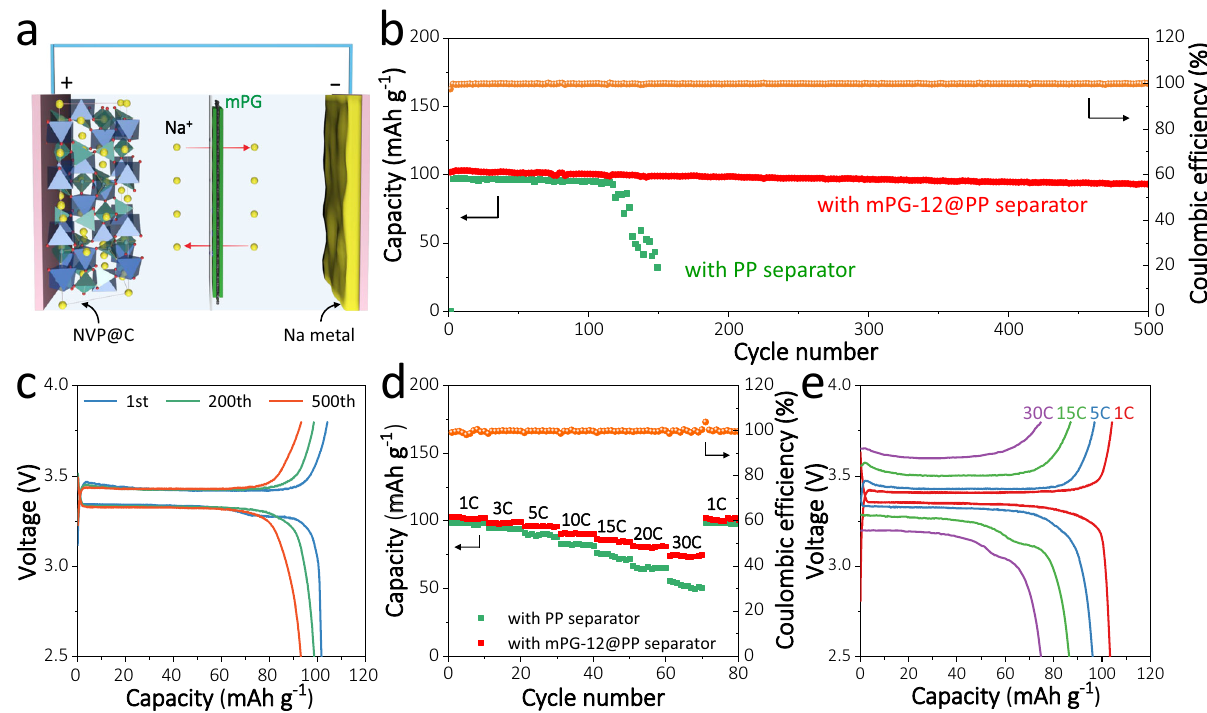
Fig. 6 Electrochemical performance of Na || NVP@C full cells with mPG-12@PP and PP separators. a Schematic illustration of Na || NVP@C full cell with mPG-coated separators. b Cycling stability obtained at a current density of 2 C. c Galvanostatic charge-discharge pro fi les of Na || NVP@C full cells with mPG-12@PP separator at 2 C (1st, 200th, and 500th cycles). d Rate capability measured from 1 to 30 C. e Galvanostatic charge-discharge pro fi les of Na || NVP@C full cells with mPG-12@PP separator obtained at varying